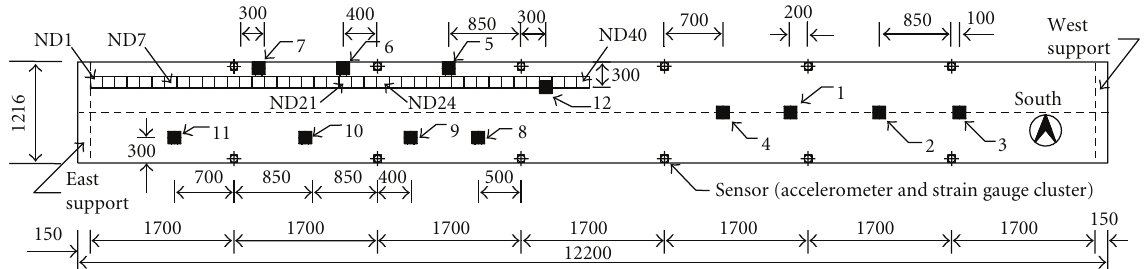
Figure 4: Schematic plan of girder showing locations of experimental damage cases (numbered and dimensioned black squares), numerical damage cases (open squares, selected cases labelled ND1, etc.), and sensors (dimensions in mm).